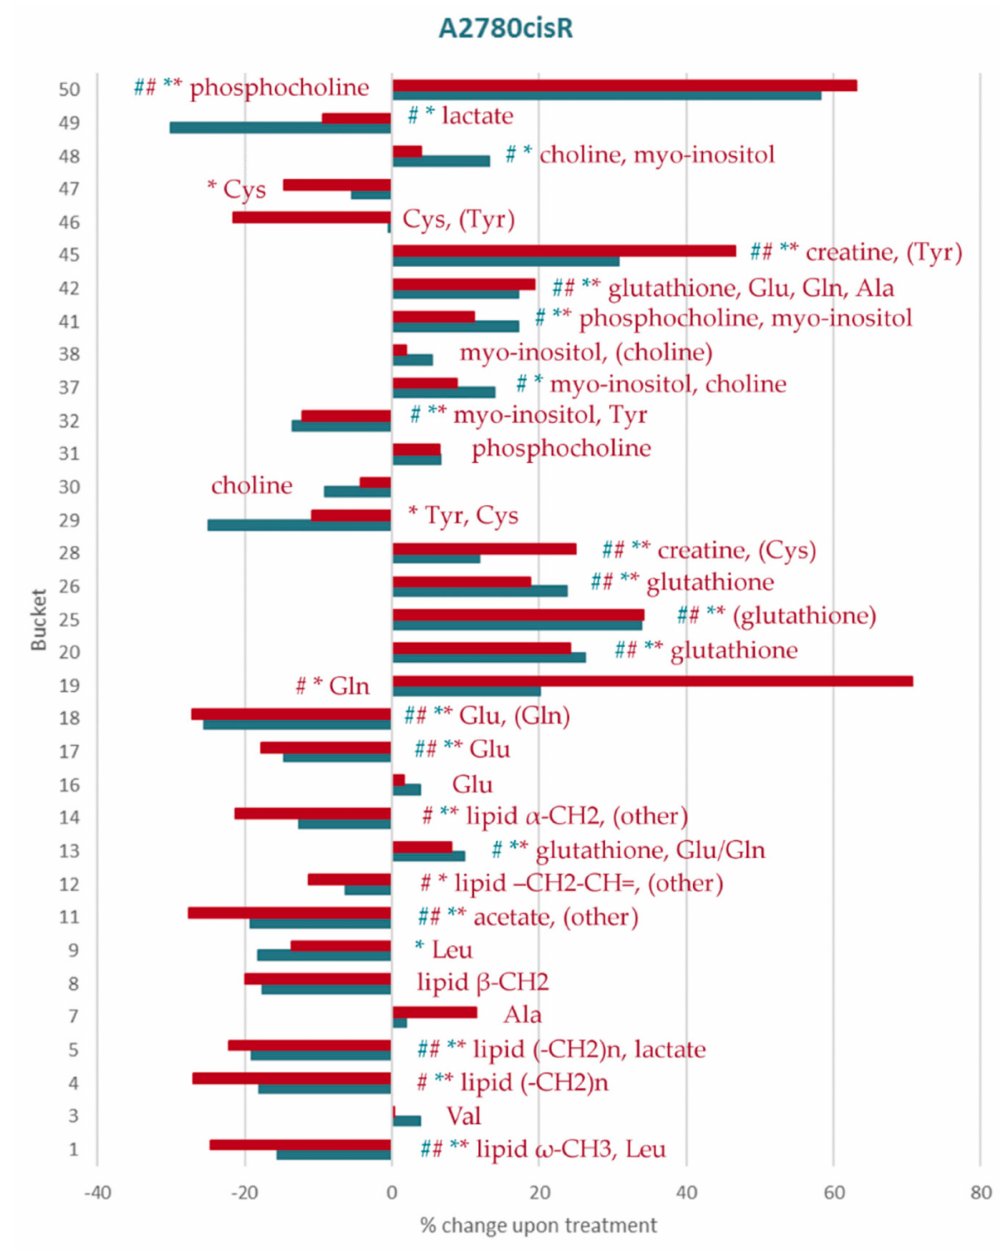
Figure 4. Percental change in the assigned aliphatic buckets in A2780cisR cells: The increasing / decreasing levels of each bucket compared to the control in cells treated with 0.015 µ M of DiRu-1 (blue) and 0.03 µ M of DiRu-1 (red) are expressed in percentages. The buckets marked with * show p -values < 0.05. The buckets marked with # show Benjamini–Hochberg-corrected p -values < 0.05. The complete bar plot also containing unidentified buckets is given in Figure